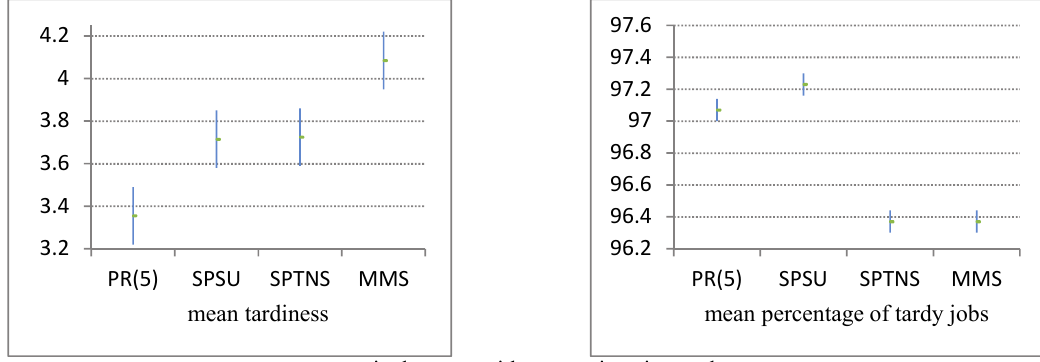
Fig. 11. Results from multiple comparison follow-up tests for mean tardiness and mean percentage of tardy jobs (single machine cases).